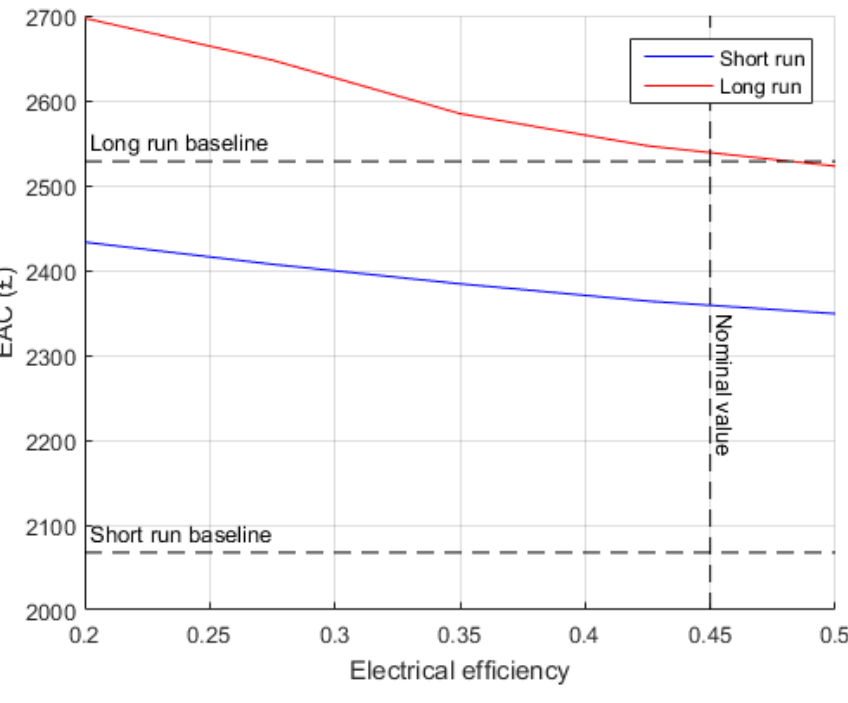
Figure 15. Influence of fuel cell design on economic performance.